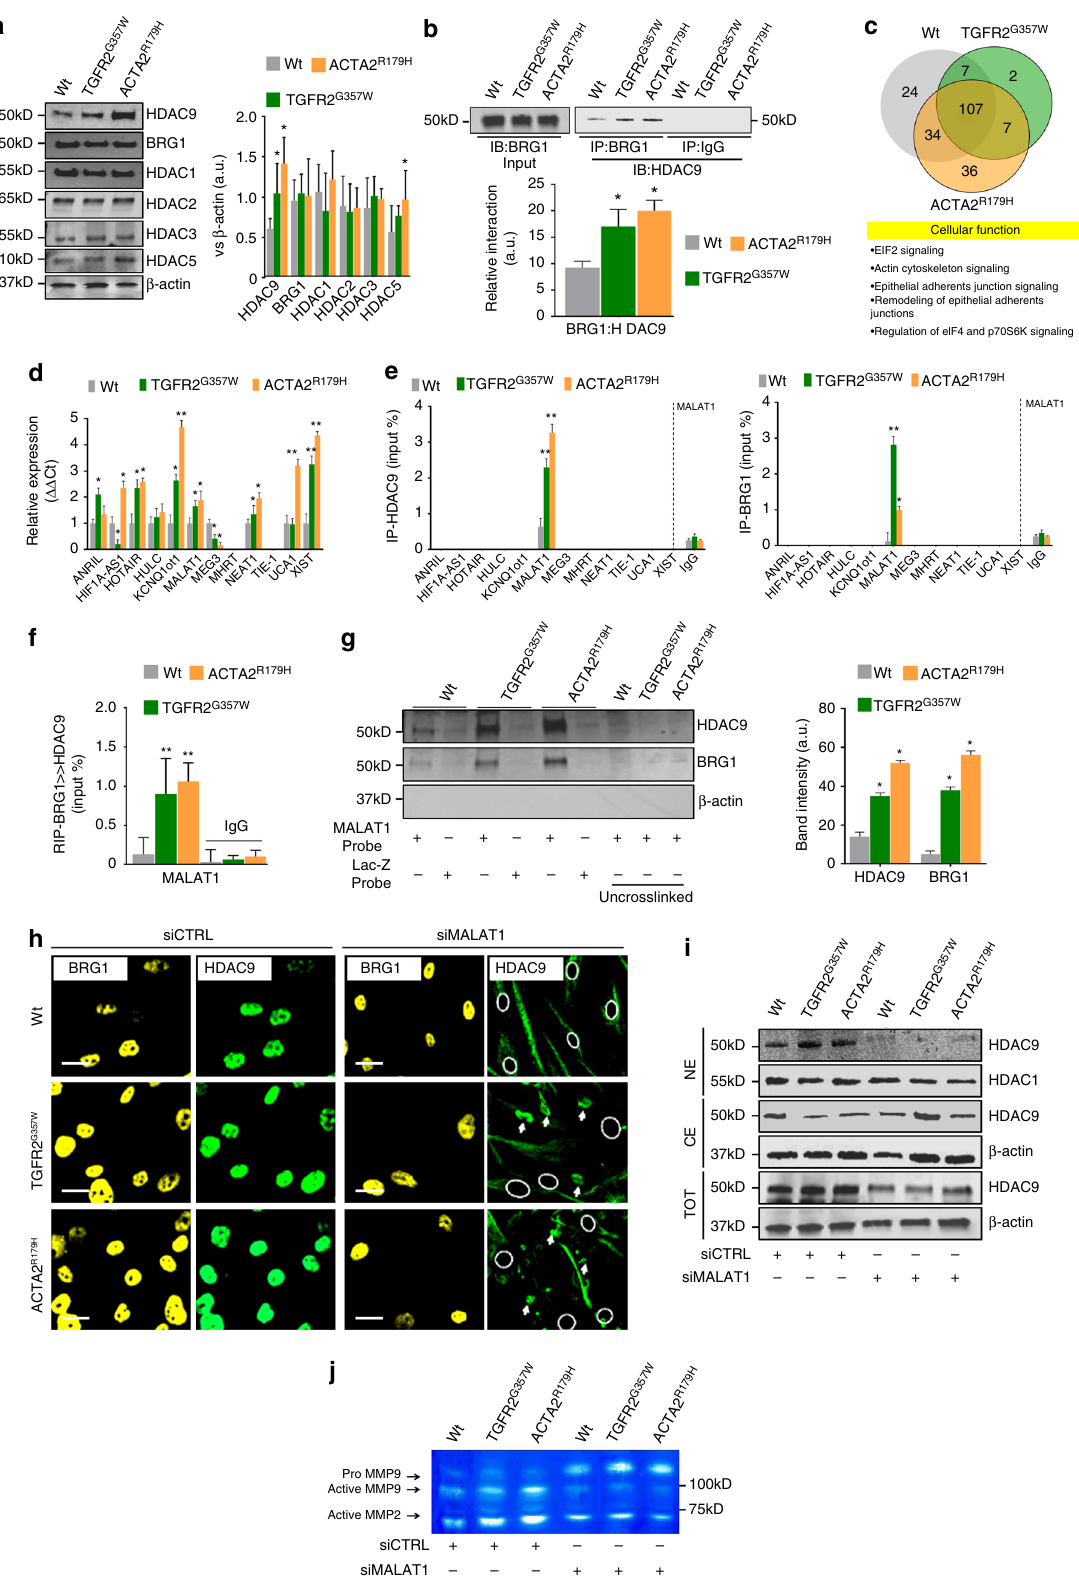
Cellular function (cid:129)EIF2 signaling (cid:129)Actin cytoskeleton signaling signaling(cid:129)Epithelial adherents junction signaling (cid:129)Remodeling of epithelial adherents (cid:129)Regulation of elF4 and p70S6K